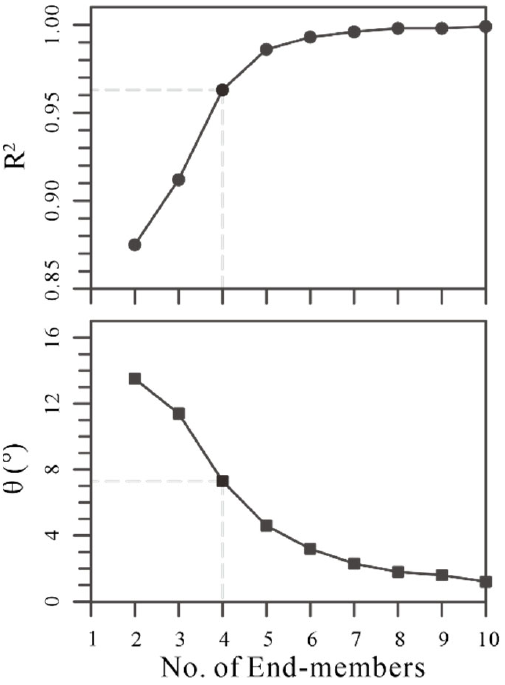
Figure 5. Coefficients of determination (R 2 ) and mean angular deviation ( θ ) as a function of the number of end ‐ members for core AGL ‐ 2010.